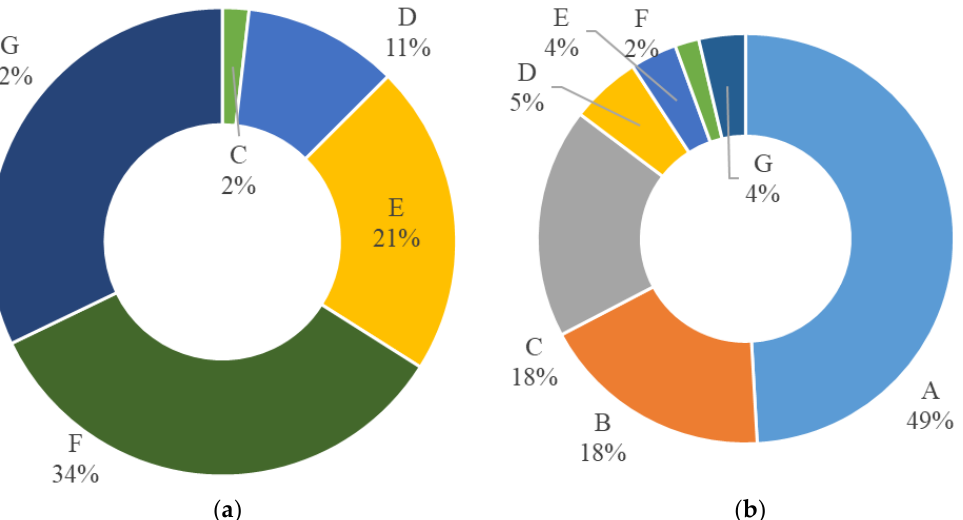
Figure 6. ( a ) Distribution of the EPC energy label regarding the heating demand and ( b ) the cooling demand.